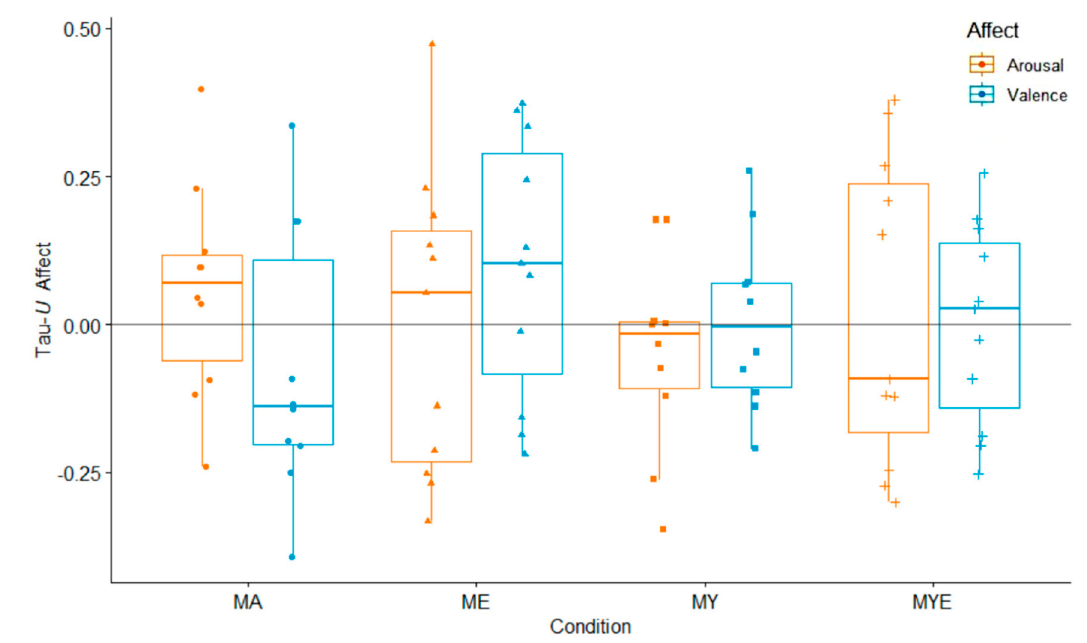
Figure 7. Box plots for averaged Tau- U arousal and valence estimates in each condition. Individual arousal and valence estimates are scattered across the box plots. Note . MA = Mantra meditation only (dots); ME = meditation and ethical education (triangles); MY = meditation and physical yoga (squares); MYE = meditation, physical yoga, and ethical education (pluses). Whiskers represent the largest and lowest values within a distance of 1.5 times the interquartile range.